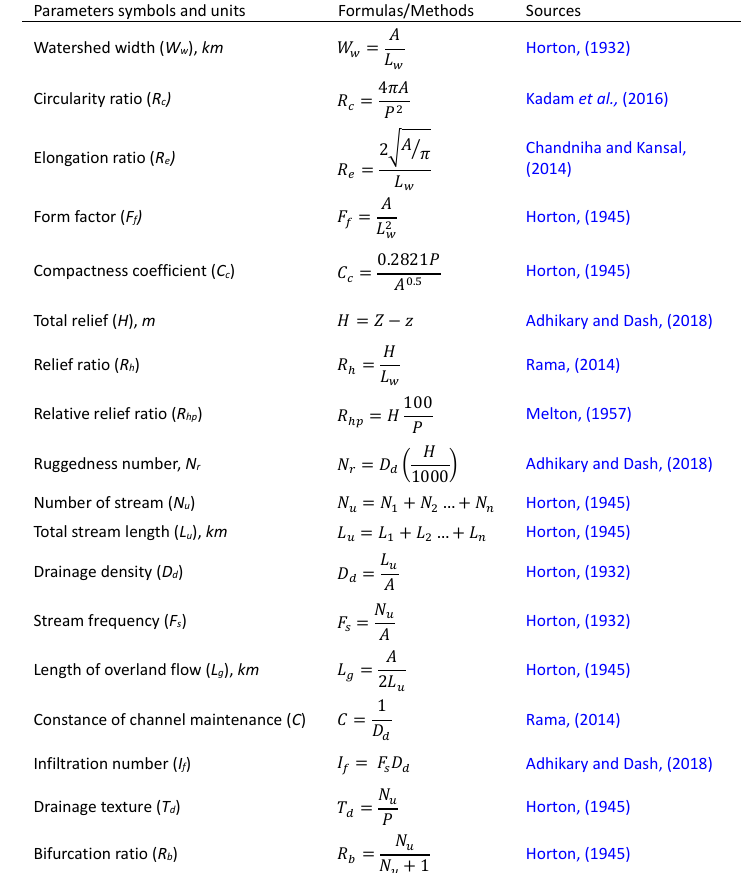
Table 1: Methods and sources used to derive watershed geomorphometric values Table 1. Methods and sources used to derive watershed geomorphometric Parameters symbols and units